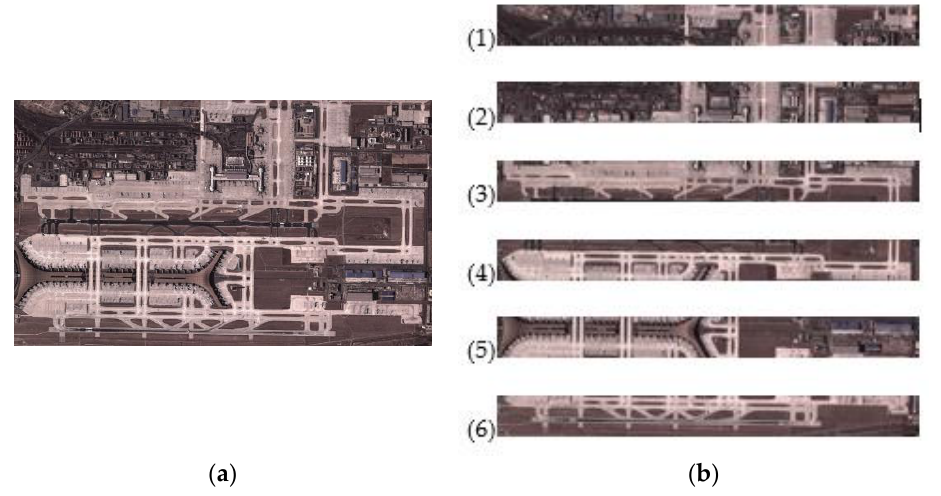
Figure 4. Segmentation result of airports with runways on more than one side of the terminal. ( a ) Original image; ( b ) segmentation result.